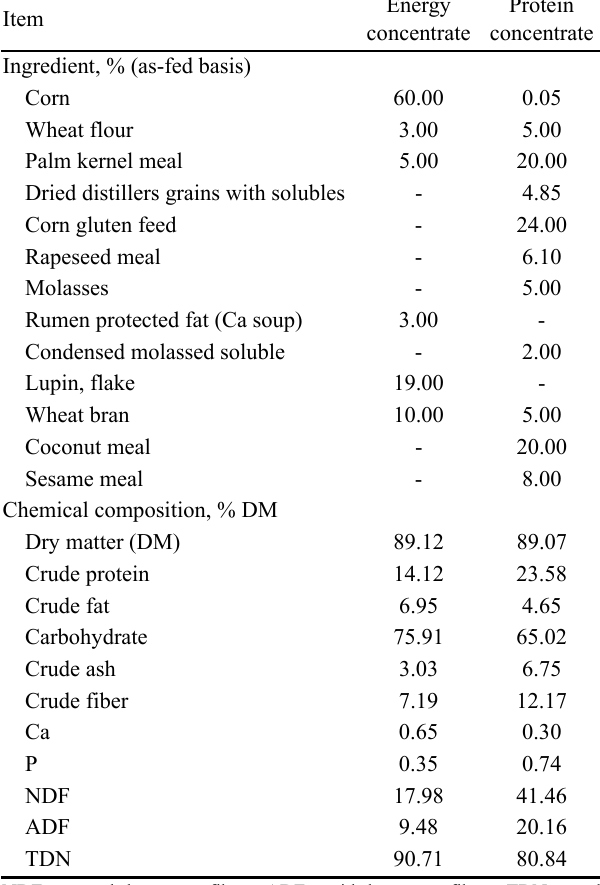
Table 2. Ingredient and chemical composition of energy and protein